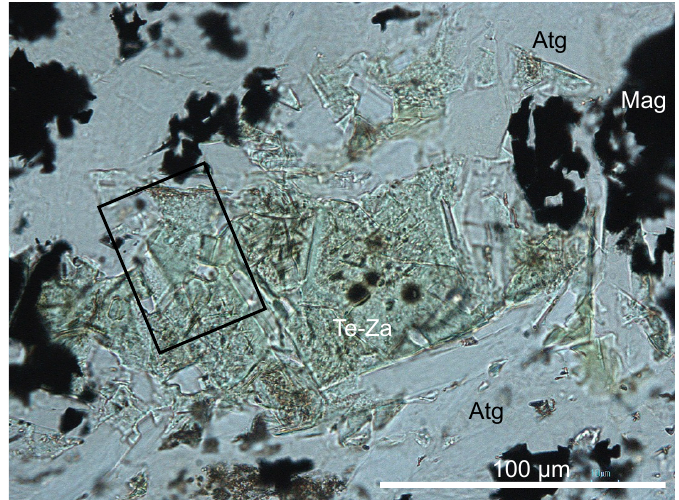
Figure 3. Discrete grain of theophrastite-zaratite aggregate (light green; Te-Za) within an antigorite-rich part. Note the penetration of antigorite laths into the aggregate. Dark spots represent damages due to the evaporation of volatiles in microprobe analysis. Plane-polarized light. The rectangle shows an area for Raman spectroscopic analysis below.